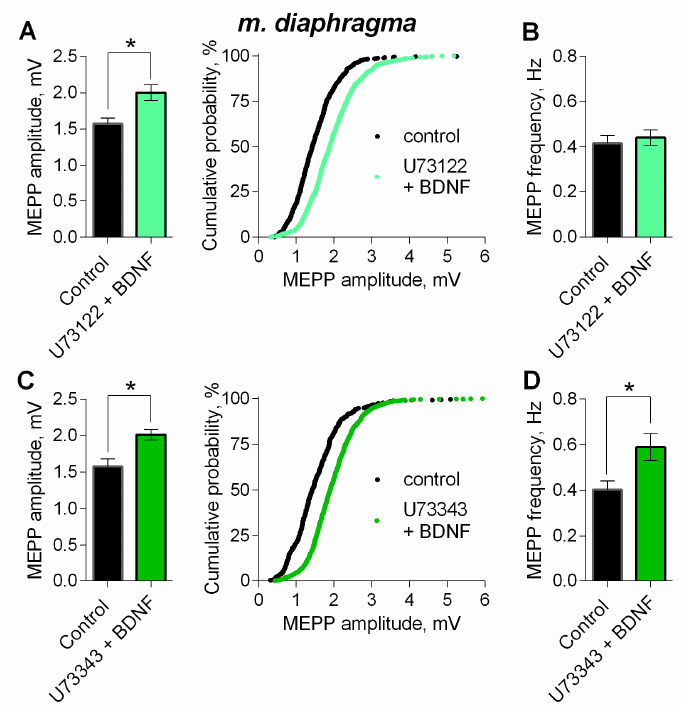
Figure 9. Intracellular signaling mechanisms underlying BDNF-induced upregulation of spontaneous neuromuscular transmission at the mouse diaphragm NMJs. PLC mediates BDNF-induced increase in MEPP frequency. ( A ) Mean amplitude of MEPPs (left) and cumulative probability plots (right) in control ( n = 25) and after BDNF was added in the presence of PLC inhibitor U73122 (5 µM) ( n = 28). ( B ) Mean frequency of MEPPs in control and upon application of BDNF in the presence of U73122. ( C ) Mean amplitude of MEPPs (left) and cumulative probability plots (right) in control ( n = 20) and after BDNF was added in the presence of preapplied inactive analog of U73122 (U73343, 5 µM) ( n = 27). ( D ) Mean frequency of MEPPs in control and upon application of BDNF in the presence of U73343. Histograms and error bars represent the mean ± SEM. * p < 0.05 compared to control.